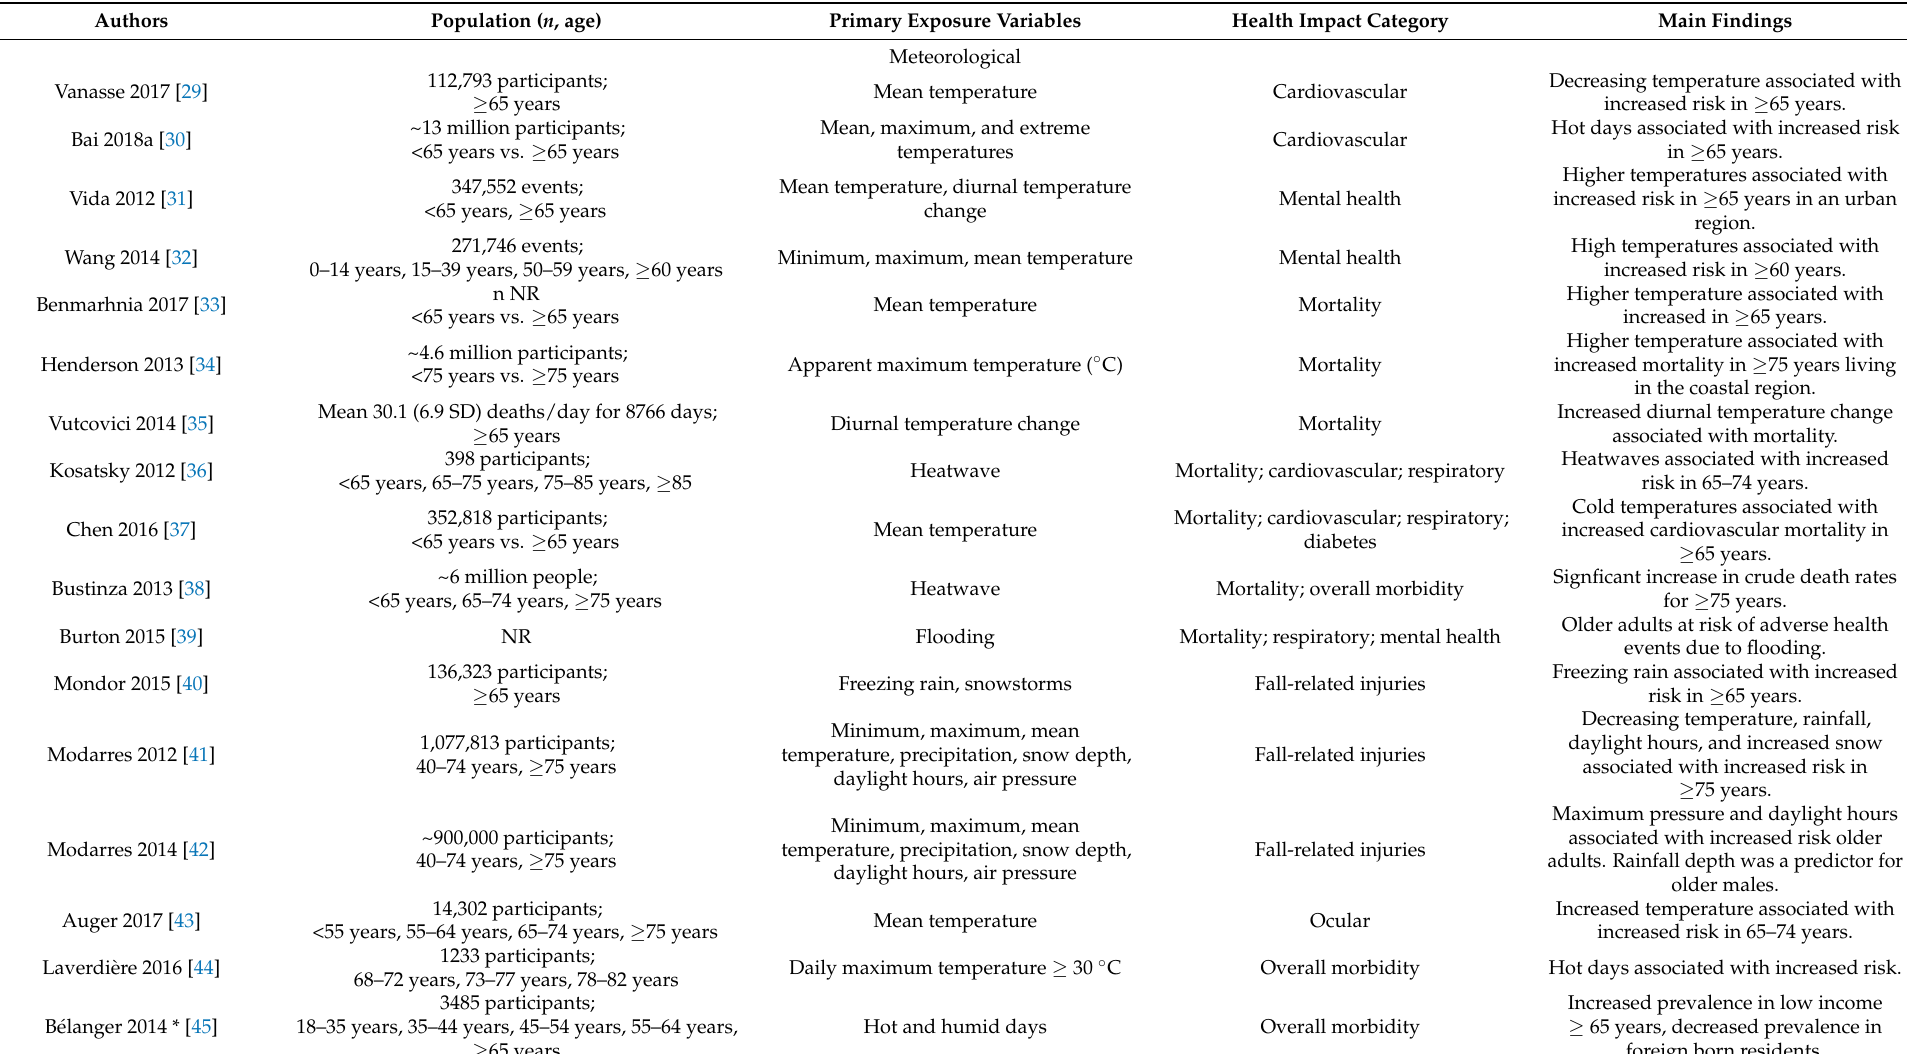
Table 1. Climatic and air pollution variables and links to health in older adults and immigrant